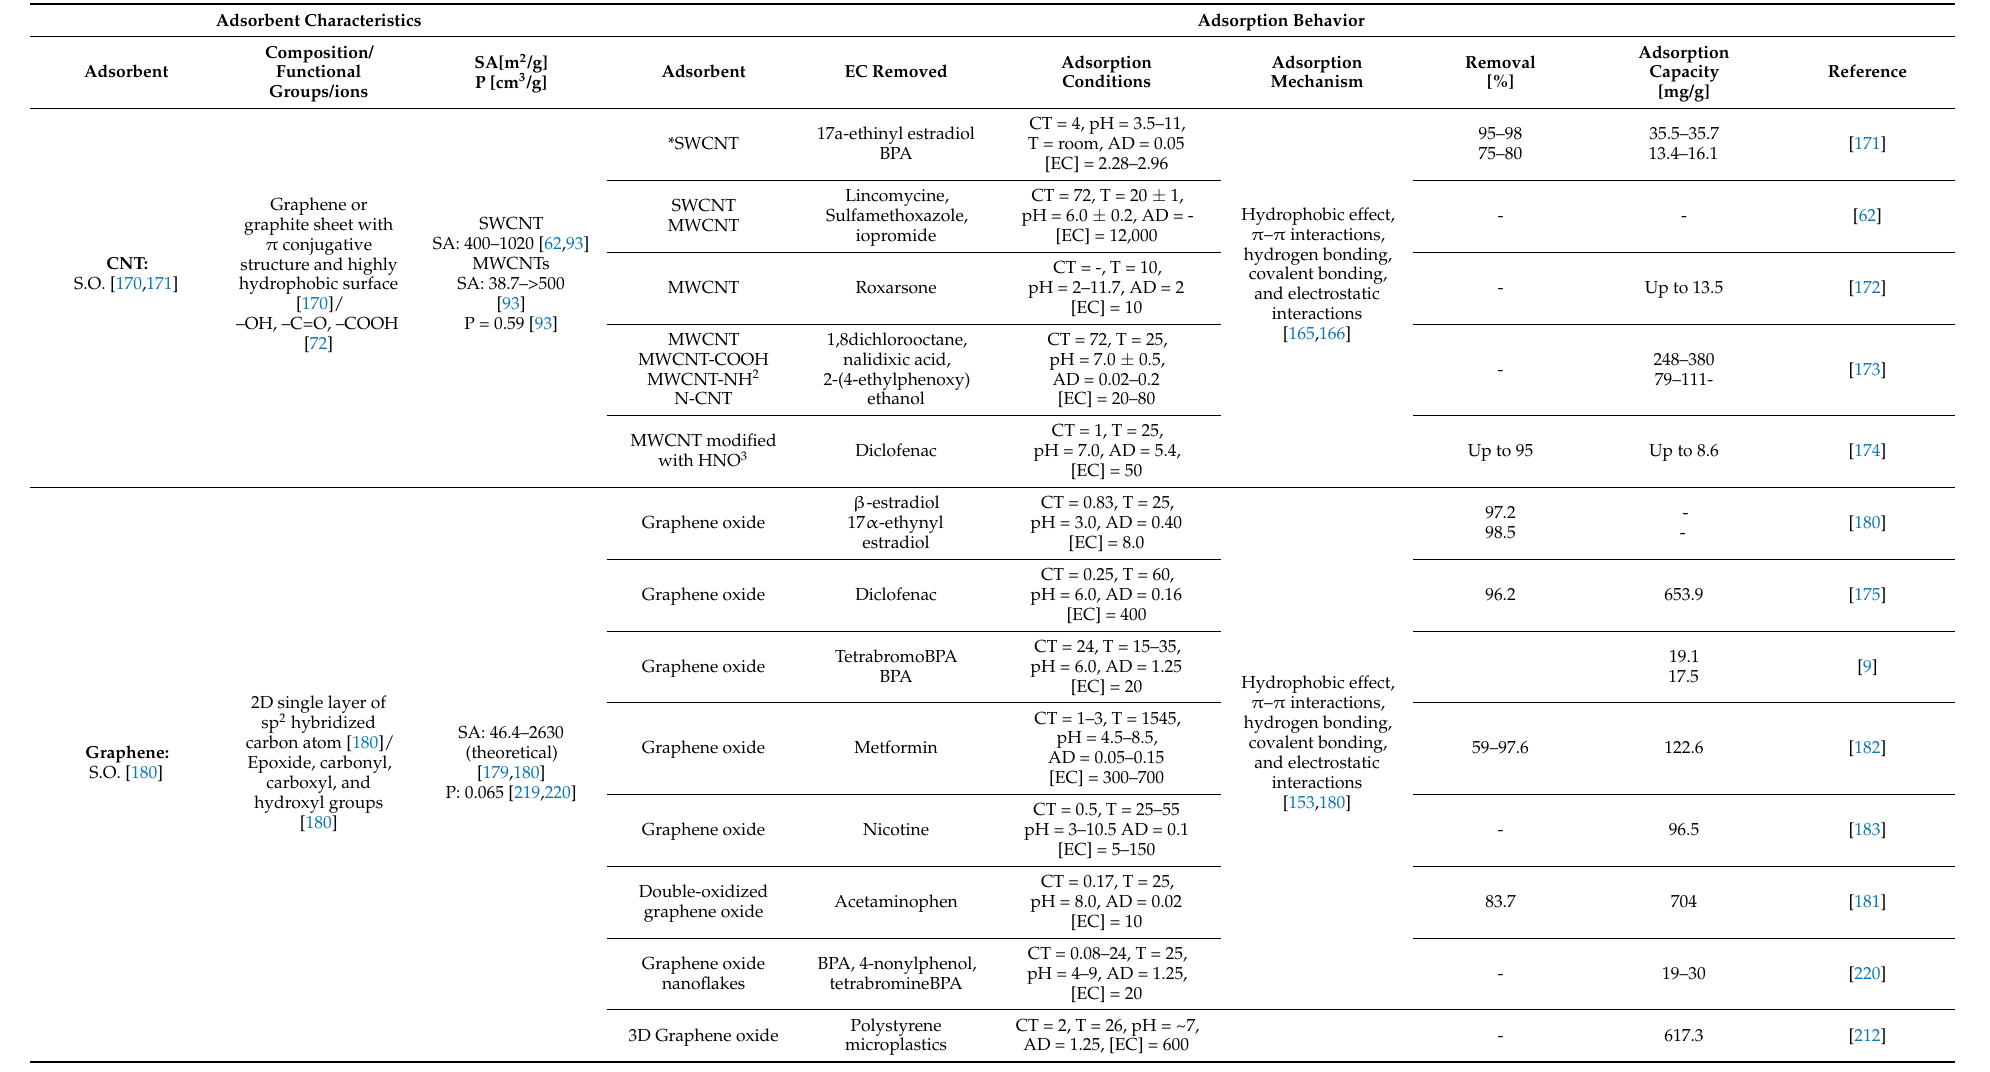
Table 5. Nanomaterials used in ECs removal using synthetic water in batch